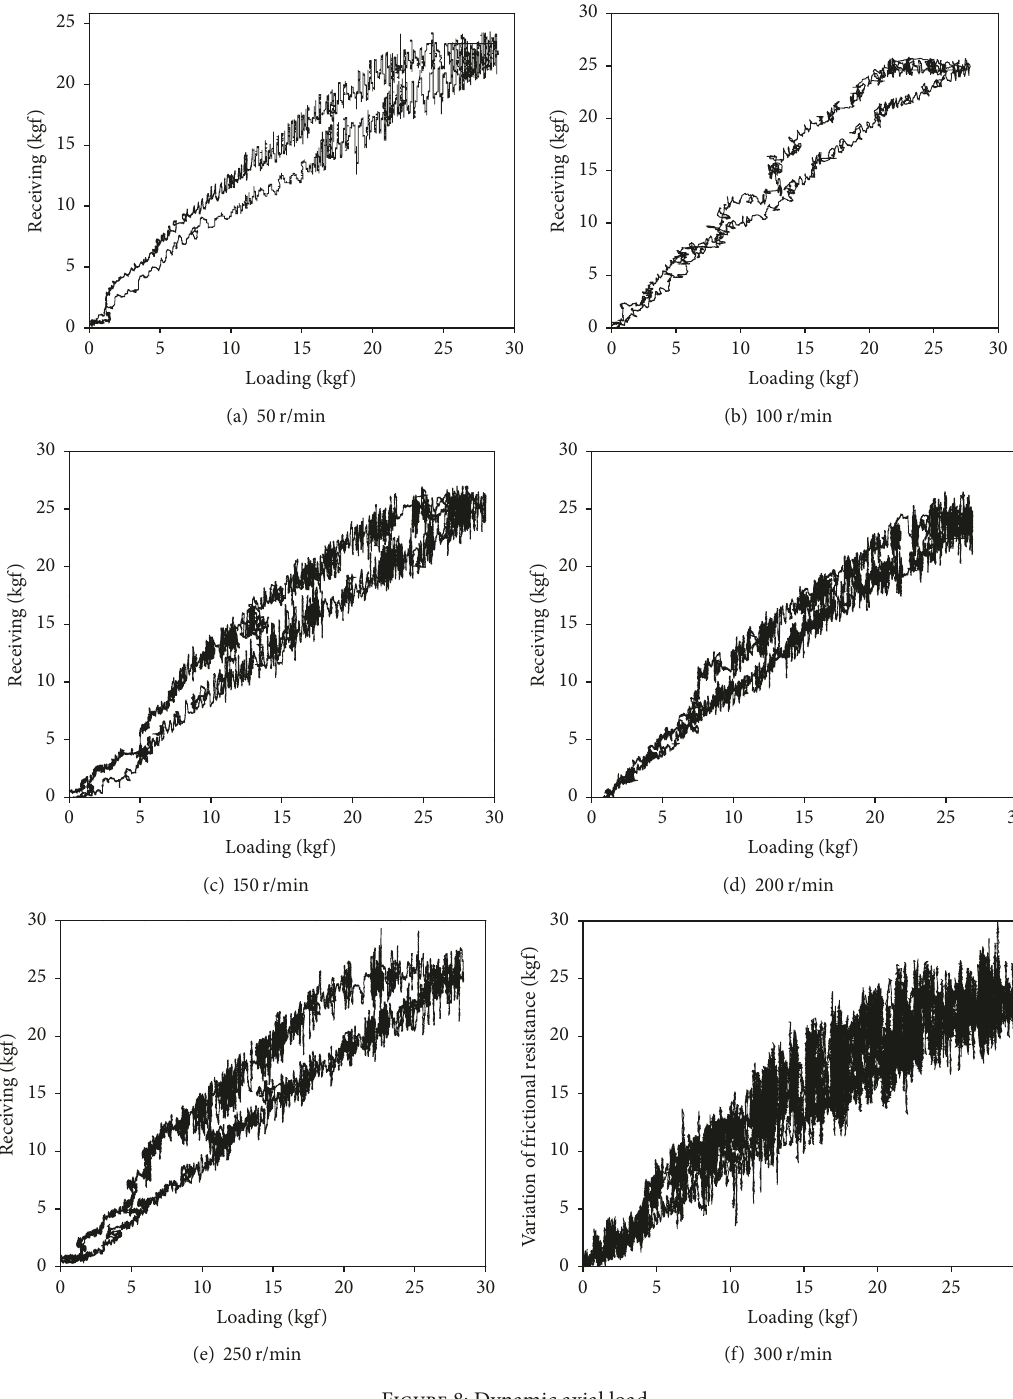
Figure 8: Dynamic axial